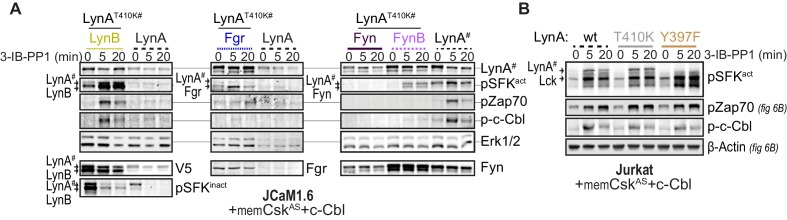
Additional immunoblots from cotransfection experiments.(A) Immunoblots showing cotransfected LynB, Fgr, and Fyn and 3-IB-PP1-mediated phosphorylation events. (B) Immunoblots from Lck-expressing Jurkat cells showing phosphorylation of activation-loop Y397 of LynAT410K, interdomain B tyrosine 319 of Zap70, and tyrosine 731 of c-Cbl due to the activity of endogenous Lck in cells cotransfected with kinase-dead LynA constructs.